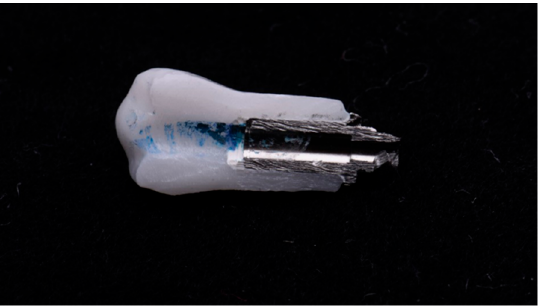
Figure 9. Subsequently, the dye penetration was evaluated under magnification. No microleakage was observed in any of the samples. The cement layer was equally distributed without any signs of penetration of the